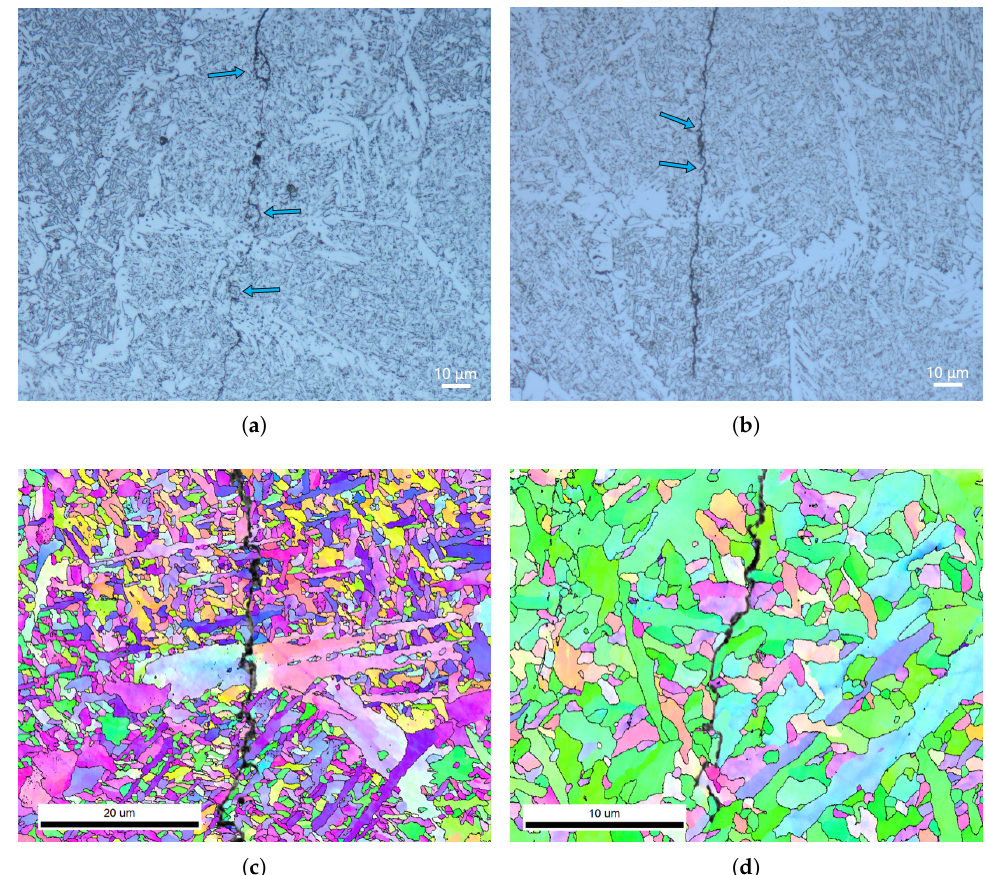
Figure 9. Crack path analysis of notched weld metal specimens. ( a ) Optical image of the crack trajectory of a 150 barg N 2 tested sample showing metal crumbs (blue arrows). ( b ) Optical image of the virtually straight crack path in a 150 barg H 2 tested sample with a minor extent of secondary cracking (blue arrows). ( c ) EBSD image of the predominant transgranular crack trajectory in a 150 barg N 2 tested sample. ( d ) EBSD image of the crack trajectory in a 150 barg H 2 tested sample showing the predominantly intergranular crack